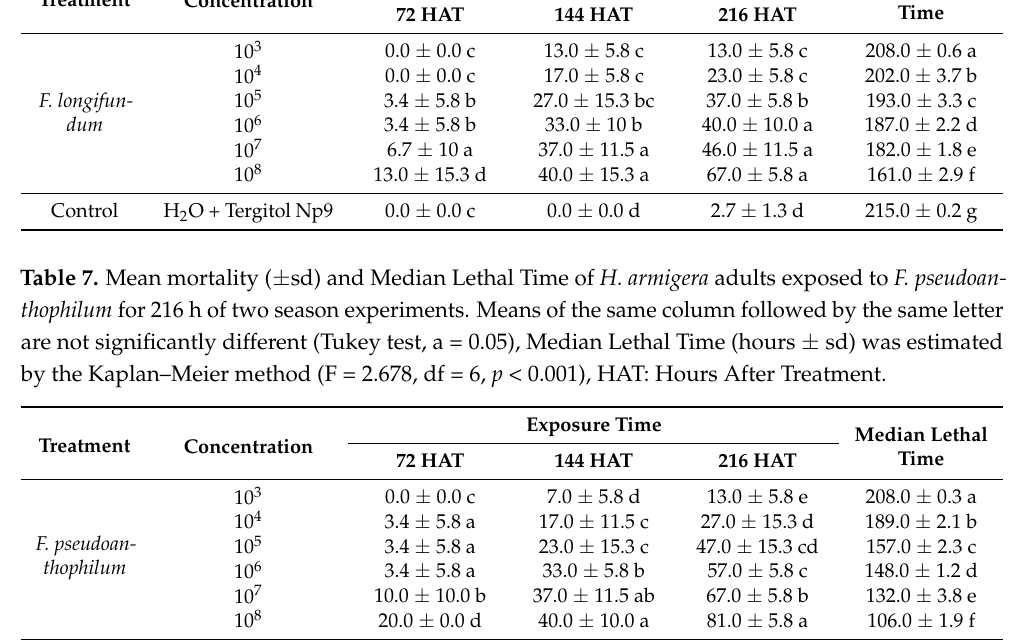
Table 6. Mean mortality ( ± sd) and Median Lethal Time of H. armigera adults exposed to F. longifundum for 216 h of two season experiment. Means of the same column followed by the same letter are not significantly different (Tukey test, a = 0.05), Median Lethal Time (hours ± sd) was estimated by the Kaplan–Meier method (F = 4.815, df = 6, p < 0.001), HAT: Hours After Treatment. Treatment